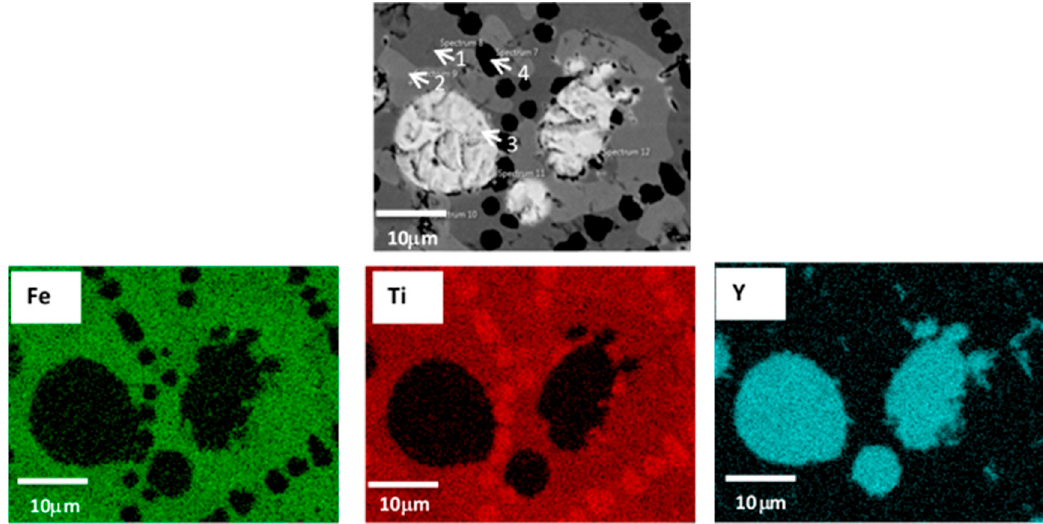
Figure 4. Backscattered micrographs of TiFe + 8 wt.% Y and the corresponding EDX mapping.